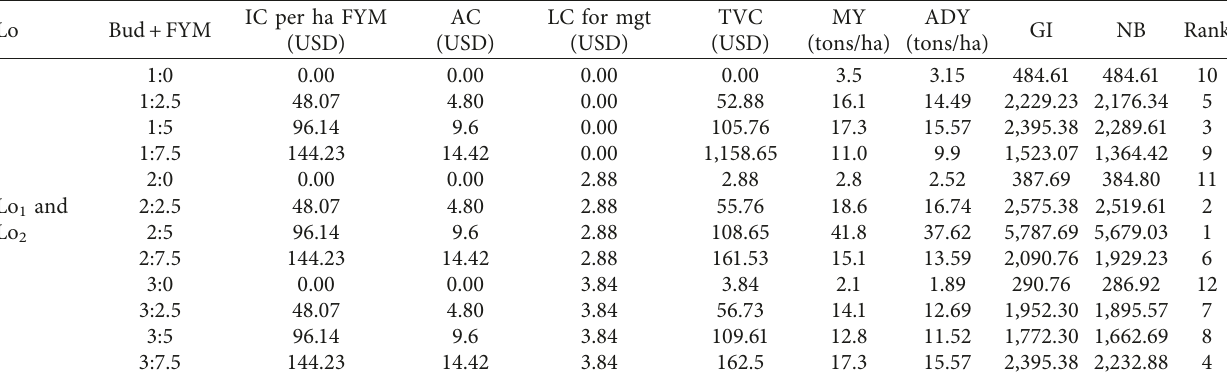
Table 7: Economic analysis of cabbage as influenced by bud number and farmyard manure fertilizer rate. IC per ha Lo Bud+FYM